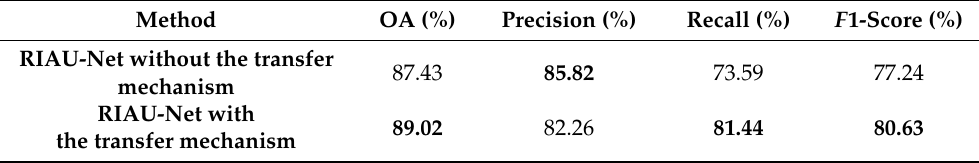
Table 7. The results of the RIAU-Net model with and without the transfer mechanism.